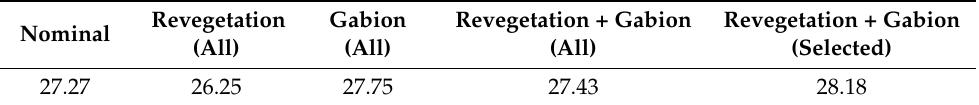
Table 5. Largest inundation width (m) near the outlet of the outlet of the area estimated using peak discharge in